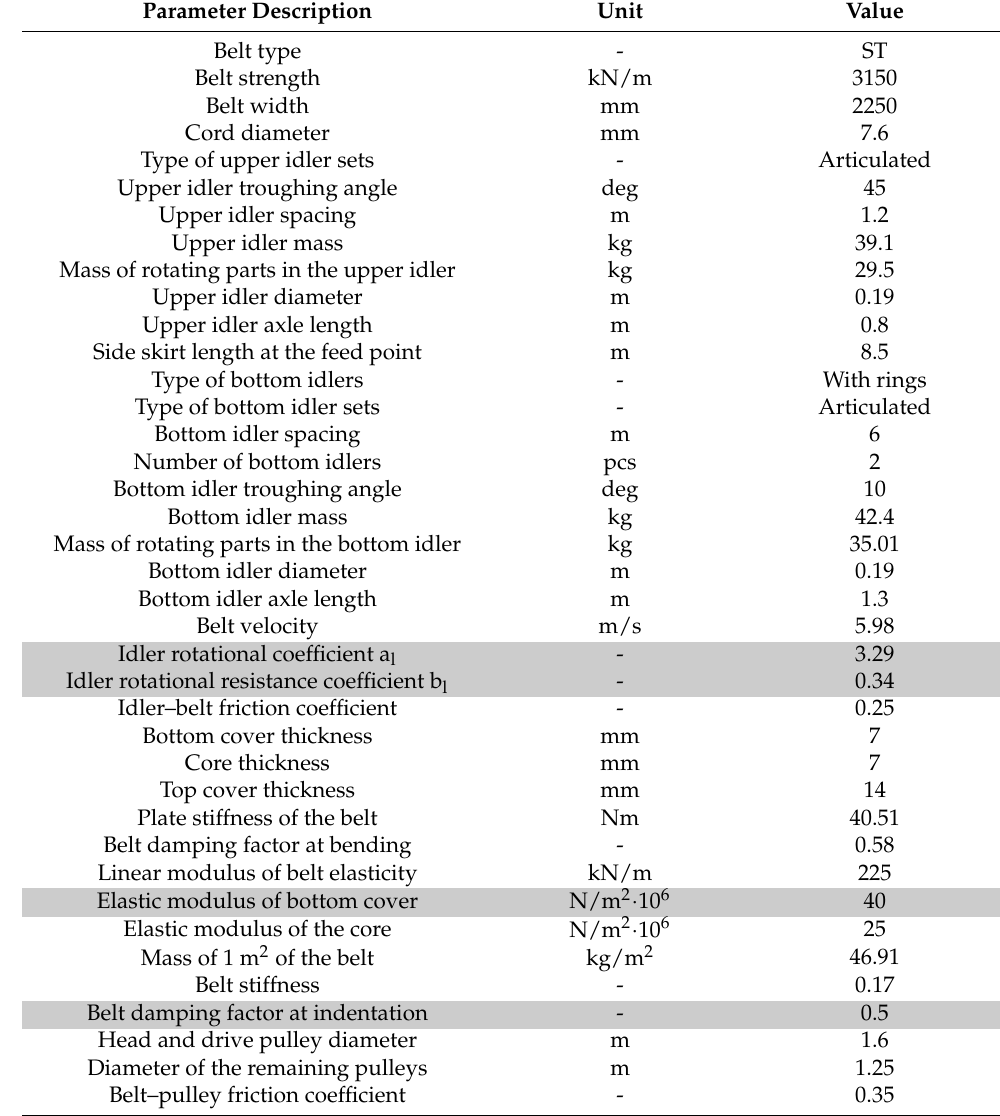
Table 7. Conveyor technical data.